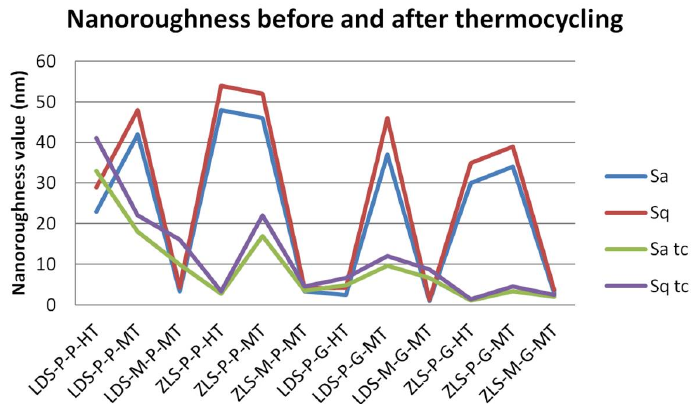
Figure 9. Results of the nanoroughness measurements before and after thermocycling.